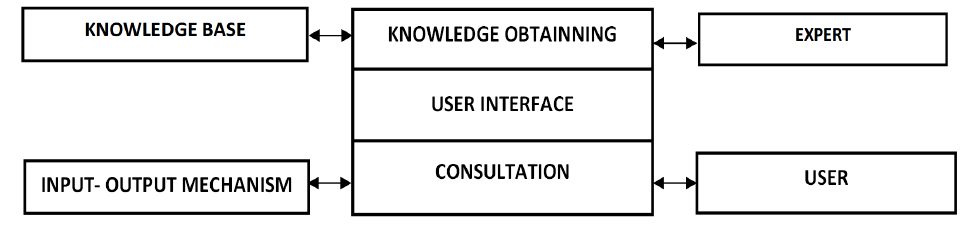
Figure 1. Basic structure of MES [40].